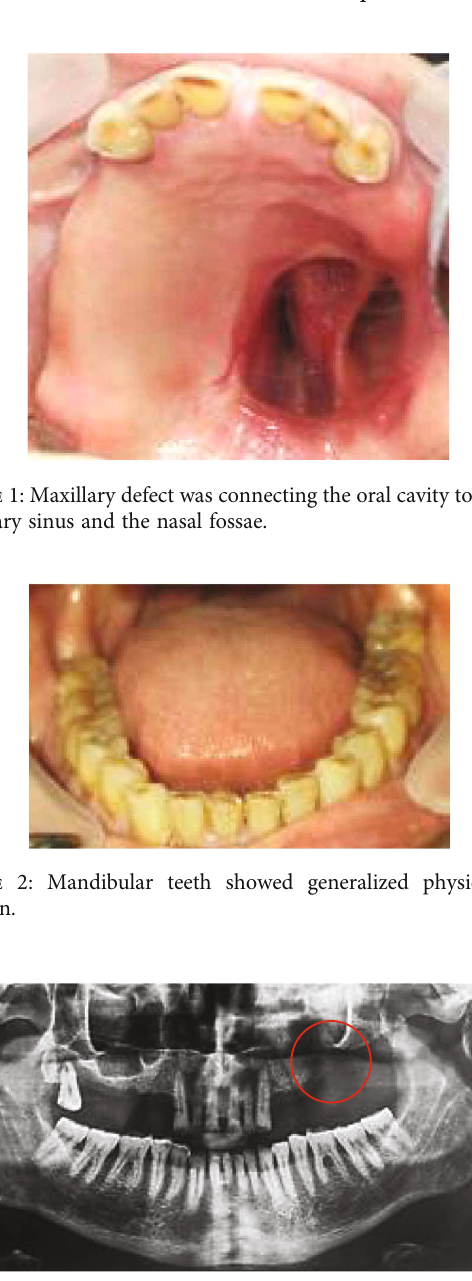
Figure 3: Panoramic radiography. The maxillary defect is shown with the circle